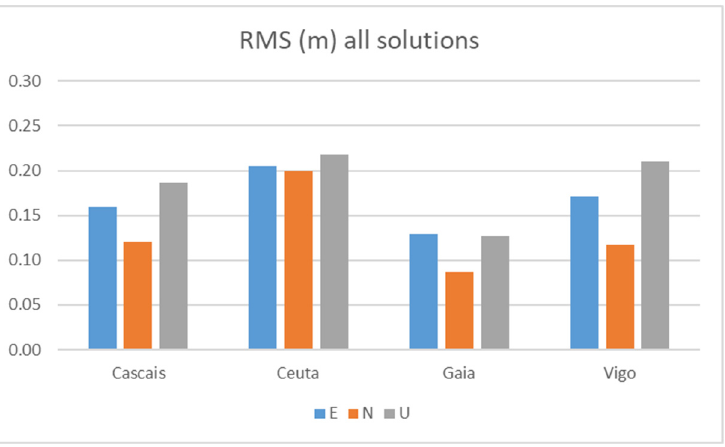
Figure 10. RMS in Test 1 of all Galileo+GPS solutions with the two smartphones.